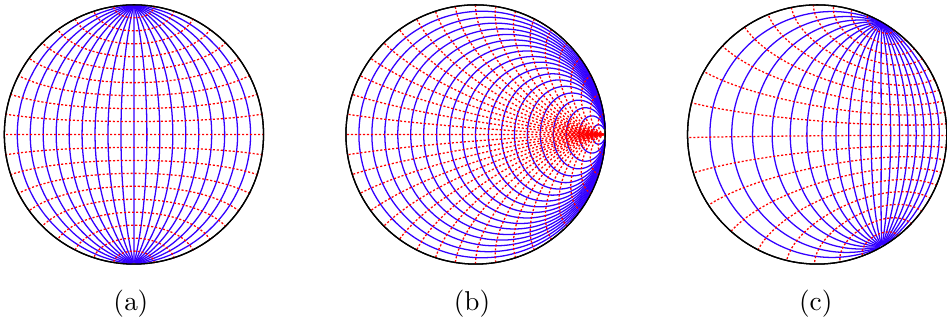
Figure 3 . Examples of (cid:13)ows (solid blue curves) induced by minimal surface foliations (dotted red curves). (While we use the coordinates of (cid:12)gure 1, we don’t maintain constant proper spacing between the treads | doing so would clump them too much near the boundary.) Such foliations are speci(cid:12)ed by the endpoints ’ of the bounding interval, as functions of (cid:21) 2 [0 ; 1] (see text for details). In particular, we illustrate foliations generating (a) antipodal threads, (b) threads with both endpoints pinned at a single point of the Poincare disk boundary, and (c) threads with endpoints pinned at generically-separated